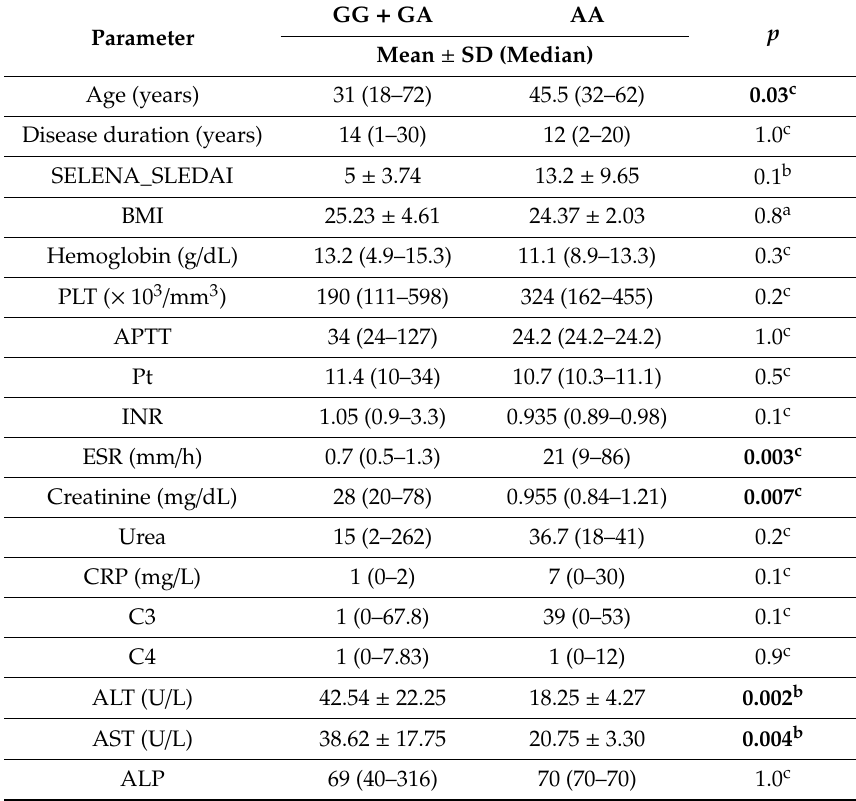
Table 6. Disease activity and laboratory variables in relation to MECP2 rs2239464 G / A, recessive